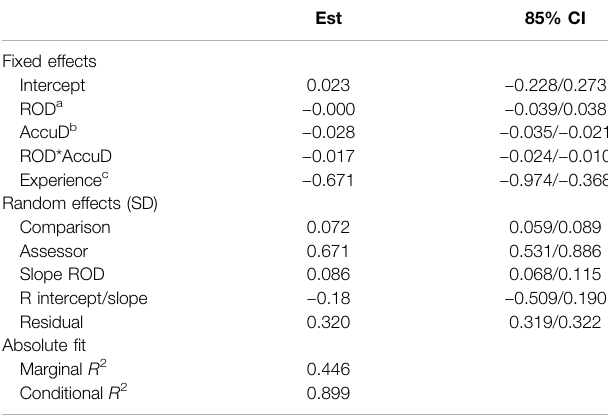
TABLE 3 | Parameter estimates (Est.), 85% con fi dence intervals (85% ci), and R 2 for Model